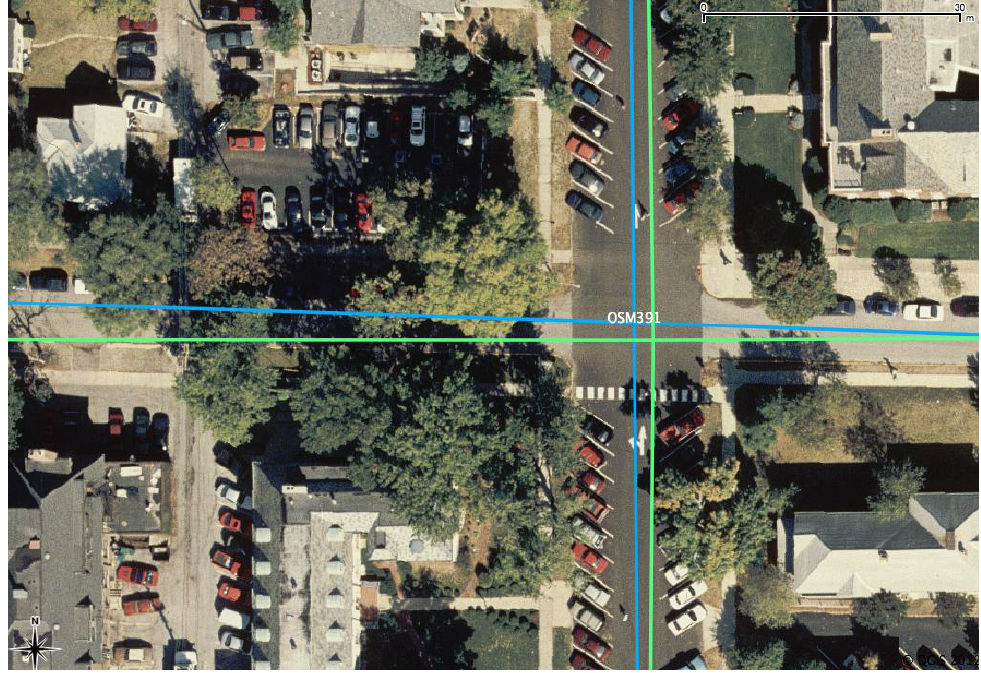
Figure 6. Close up area 2.